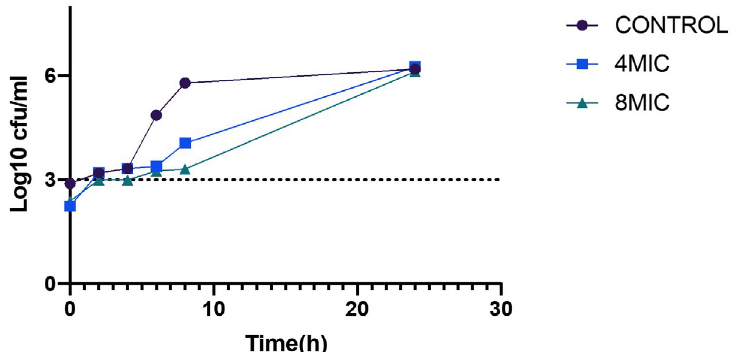
Fig. 13. Time kill curve of Acetone extract on Staph.aureus (Clinical isolate).